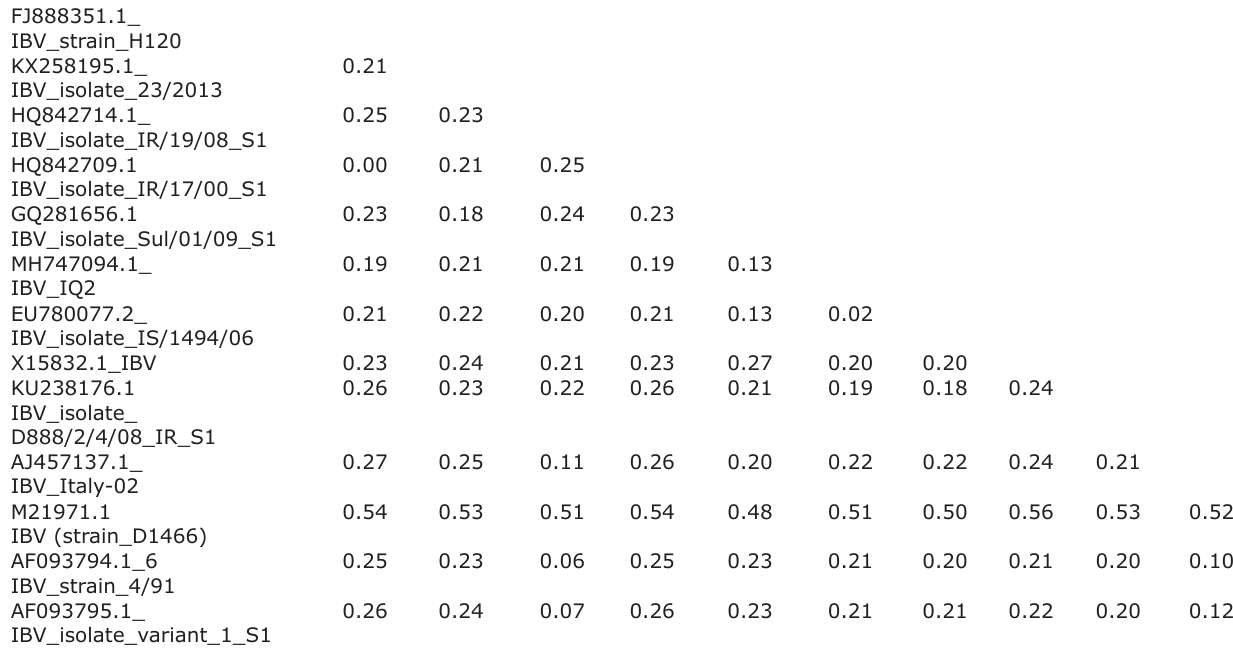
Table-2: Percentage of nucleotide divergence of IBV-IQ2 strain in comparison to 12 IBV published isolates calculated by Mega X software. FJ888351.1_